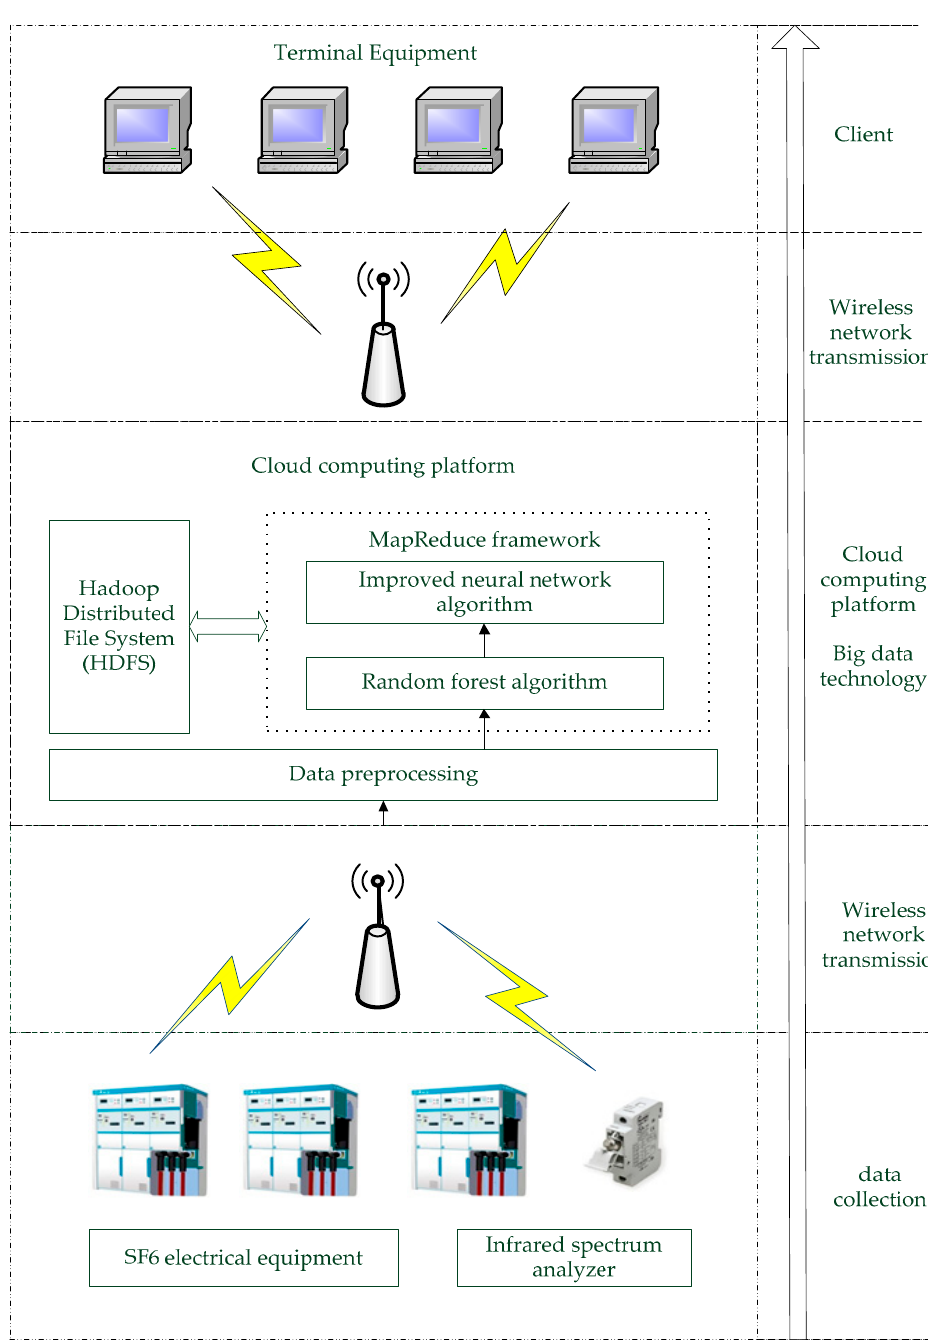
Figure 3. Architecture of the two-level fault diagnosis system for SF6 electrical equipment.